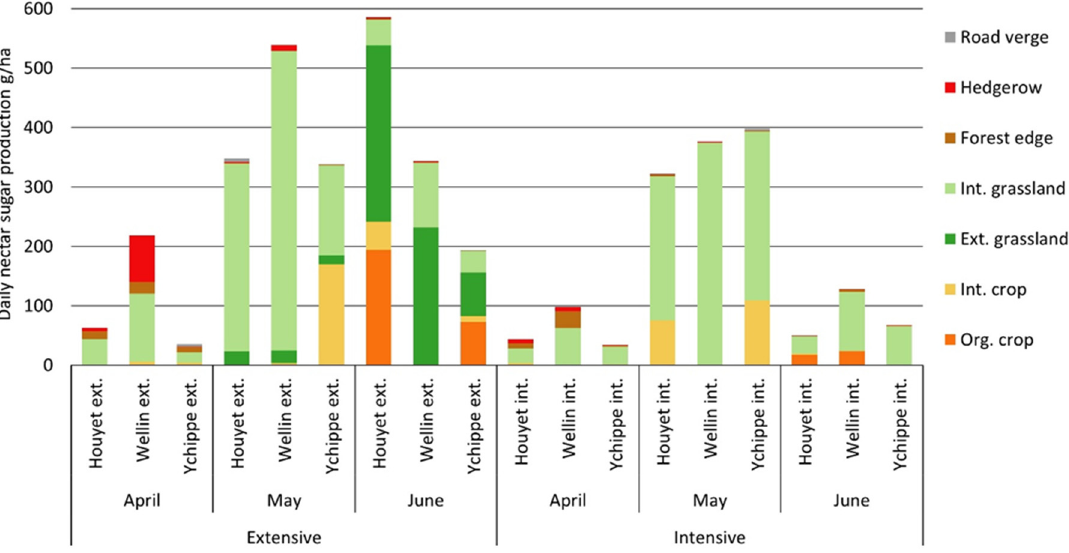
Table 3. Mean daily nectar sugar production at the landscape scale and mean pollinators abundance per site between extensive and intensive landscape. Extensive Landscapes